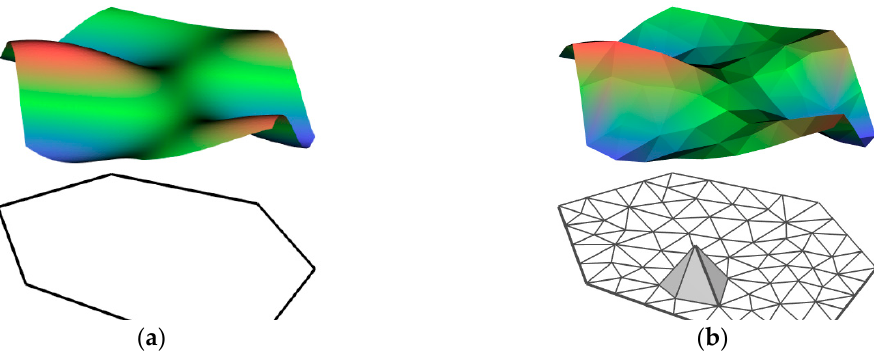
Figure 1. A continuous Gaussian field ( a ) was approximated by a Gaussian Markov field( b ).